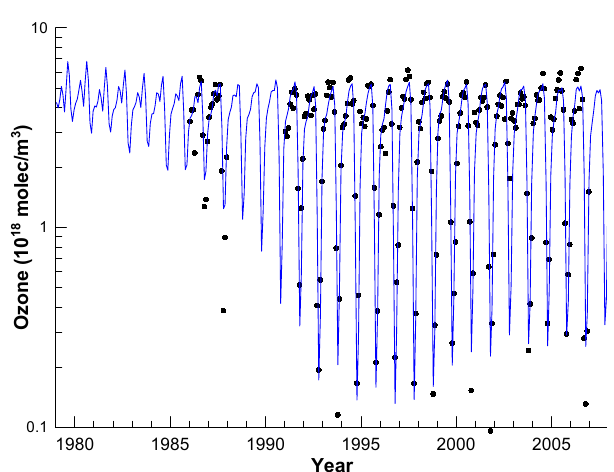
Figure 8. As for Fig. 8 but for 85 ◦ S to 90 ◦ S. Fig. 8. As for Figure 8 but for 85 ◦ S to 90 ◦ S. Fig. 8. As for Figure 8 but for 85 ◦ S to 90 ◦ S.